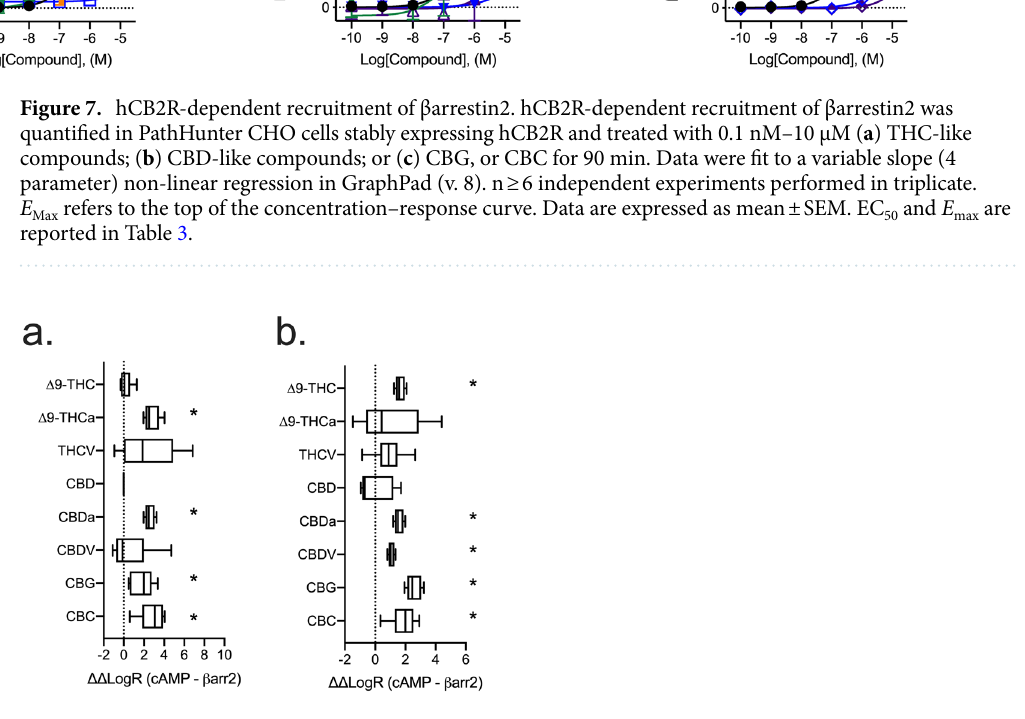
Figure 8. Analysis of ligand bias for phytocannabinoids at hCB1R ( a ) and hCB2R ( b ). Data from cAMP inhibition assays (Figs. 2, 5) and βarrestin2 recruitment assays (Figs. 3, 6) were fit to the operational model of Black and Leff (1983) using CP55,940 as the reference agonist and bias factor—reported here as ∆∆LogR— was calculated for each ligand between inhibition of FSK-stimulated cAMP accumulation and βarresitn2 recruitment. n ≥ 6 independent experiments performed in triplicate. Data are expressed as mean ± 95% CI (box) and minimum and maximum observed values (whiskers). *p < 0.05 relative to 0 as determined by non- overlapping 95%